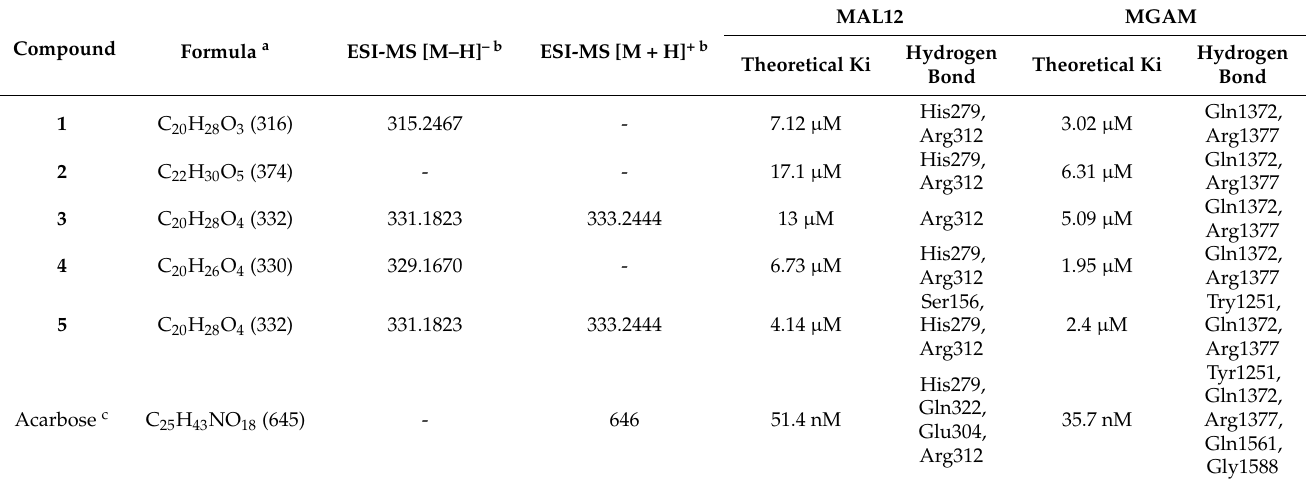
Figure 6. HPLC-MS spectrum obtained from the affinity screening analysis of an EWE soluble extract with α -glucosidase: ( A ) the free ligand ( m / z 329.1670 [M–H] – ; 27.98–28.09); ( B ) the free ligand ( m / z 331.1823 [M–H] – ; 28.84–28.94 min), and ( C ) the free ligand ( m / z 315.2467 [M–H] – ; 31.80–32.40 min). Table 4. Clerodanes identification with α -glucosidase enzyme and docking